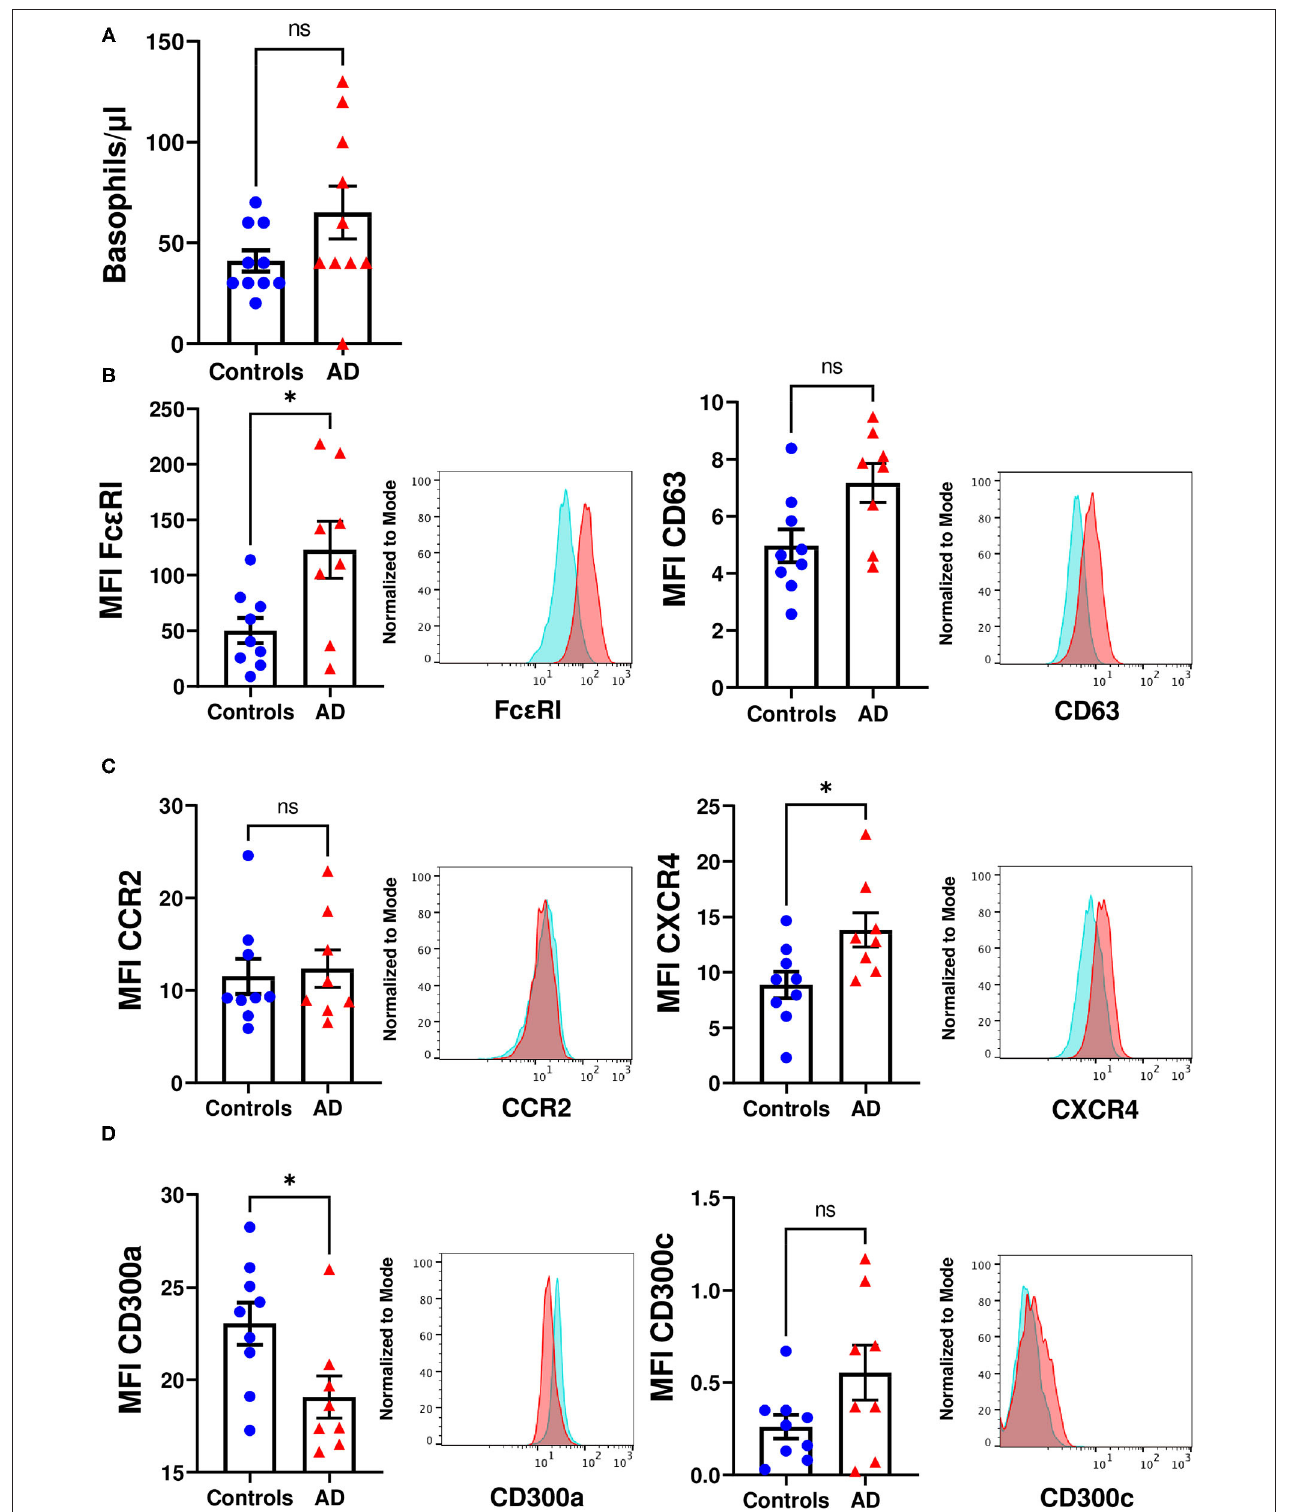
FIGURE 2 | Phenotypic characterization of basophils from moderate-to-severe AD children. (A) Dot-bar graphs showing the number of basophils/ul in healthy control (blue dots) and moderate-to-severe AD (red triangles) children’s whole blood. (B–D) Dot-bar graphs showing MFI of Fc ε RI, CD63, CCR2, CXCR4, CD300a, and CD300c on circulating basophils from healthy control (blue dots) and moderate-to-severe AD (red triangles) children and histograms of representative individuals (healthy control in blue and AD patients in red). Each dot represents a donor, means ± SEMs are shown. Mann–Whitney test. ns, no significant, * p < 0.05.